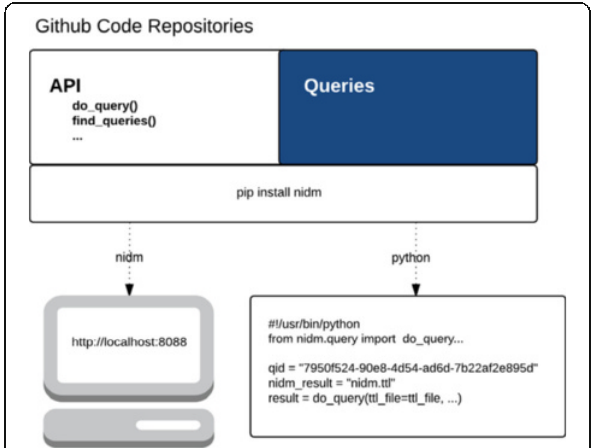
Fig. 17 (abstract A21). The nidm-api (nidm) provides programmatic access to queries in the nidm-query repository, including RESTful ac- cess (left panel) and access from python applications (right panel)